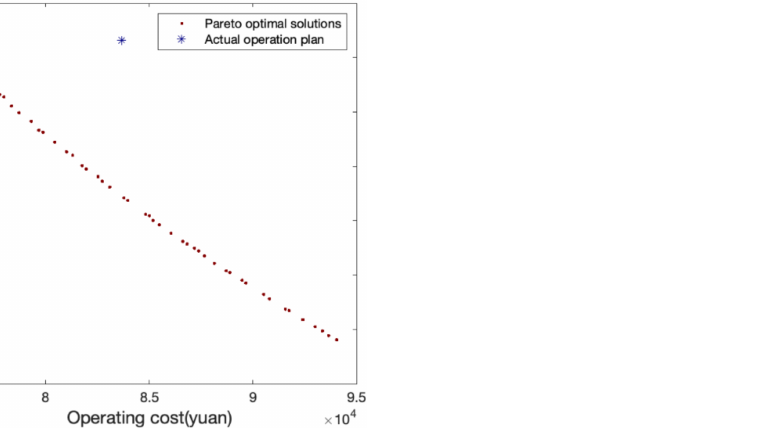
Figure 11. The object function value distributions of Pareto frontier solutions and actual operation plan.